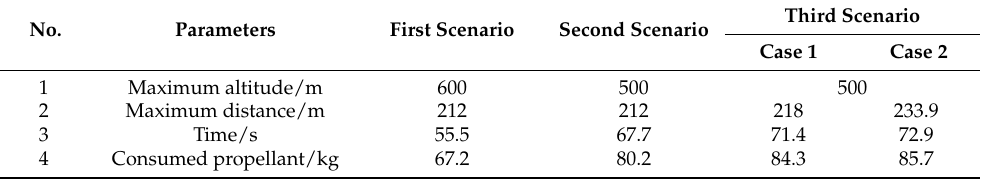
Table 5. Comparison of results for the three flight